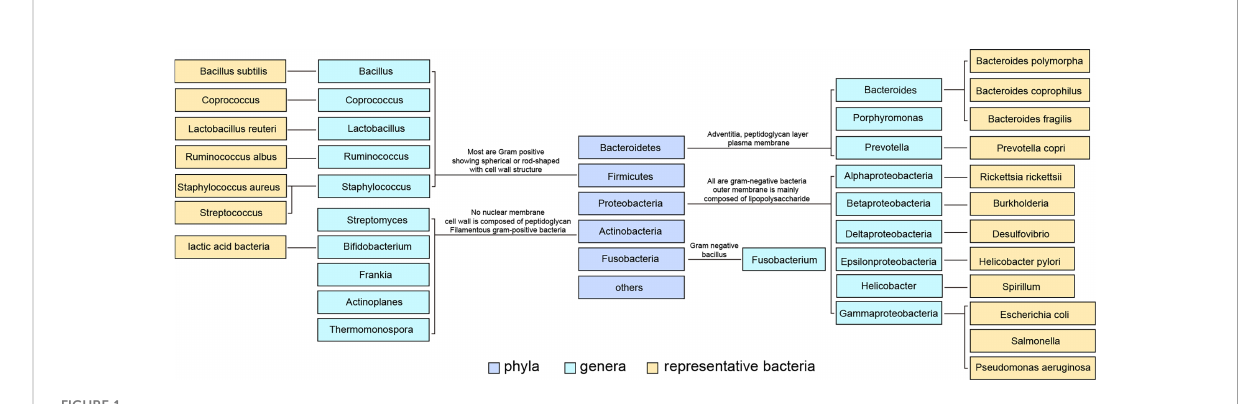
FIGURE 1 Classi fi cation of common intestinal fl ora and some representative fl ora. Intestinal bacteria are divided into phyla phylum, class, order, family, genus and species according to their grades. The content of Firmicutes in normal intestinal fl ora was the highest, and Bacteroidetes ranked